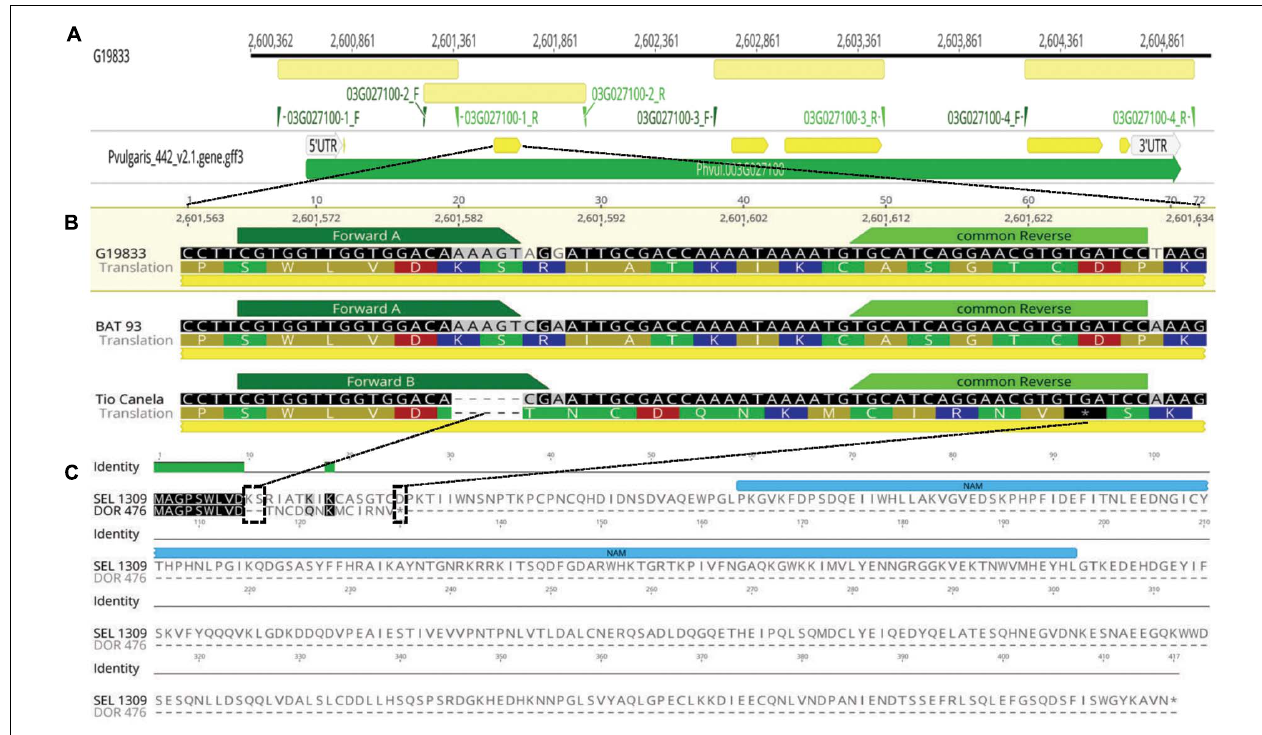
FIGURE 1 | Candidate Phvul.003G027100 NAC gene model for bgm-1 in Phaseolus vulgaris: (A) Four primer pairs designed for amplifying the six exons of candidate gene Phvul.003G027100 ( Supplementary Table 1B ). Physical positions from reference genome v2.1 (G19833). (B) T m -shift-assay marker (PvNAC1) designed for amplification of 5 bp indel region in second exon of Phvul.003G027100 in accessions G19833 ( Bgm-1 ), BAT 93 ( Bgm-1 ) and Tio Canela 75 ( bgm-1 ). (C) Protein alignment of Phvul.003G027100 candidate gene for bgm-1 (DOR 476) revealed a stop-gain mutation in position 23. Effect of the indel frameshift mutation on transcription of the candidate gene among ten lines—three with and seven without bgm-1 modeled by Geneious R (cid:13) 9.1.8 software.